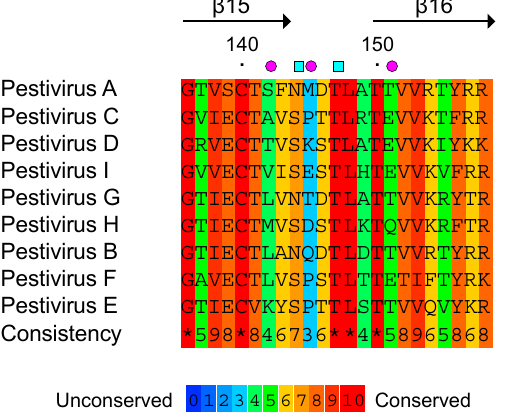
Figure 1. Conservation analysis of amino acids encompassed in the solvent exposed β -hairpin motif of BVDV E2. ( A ) Amino acid alignment of the β -hairpin motif of Pestivirus E2. PRALINE [27] multiple sequence alignment method was used to calculate amino acid conservation. Genebank Accession numbers for Pestivirus sequences were retrieved from [1]. Pestivirus A (BVDV-1/M96751), Pestivirus B (BVDV-2/AF002227), Pestivirus C (CSFV/AF326963), Pestivirus D (BDV/AF037405), Pestivirus E (pronghorn pestivirus/AY781152), Pestivirus F (BuPV/EF100713), Pestivirus G (giraffe pestivirus/AF144617), Pestivirus H (Hobi-like pestivirus/FJ040215), Pestivirus I (Aydin-like pestivirus/JX428945). Magenta circles indicate residues involved in antibody escape in CSFV [21] and cyan squares the amino acids mutated to Ala in this study. ( B ) Cartoon representation of BVDV E2 fold (PDB 4JNT) was prepared with VMD software [28]. Mutated amino acids Asn144 and Thr147 are depicted as stick representations. Cyan and purple spheres correspond to the shapes shown in ( A ).